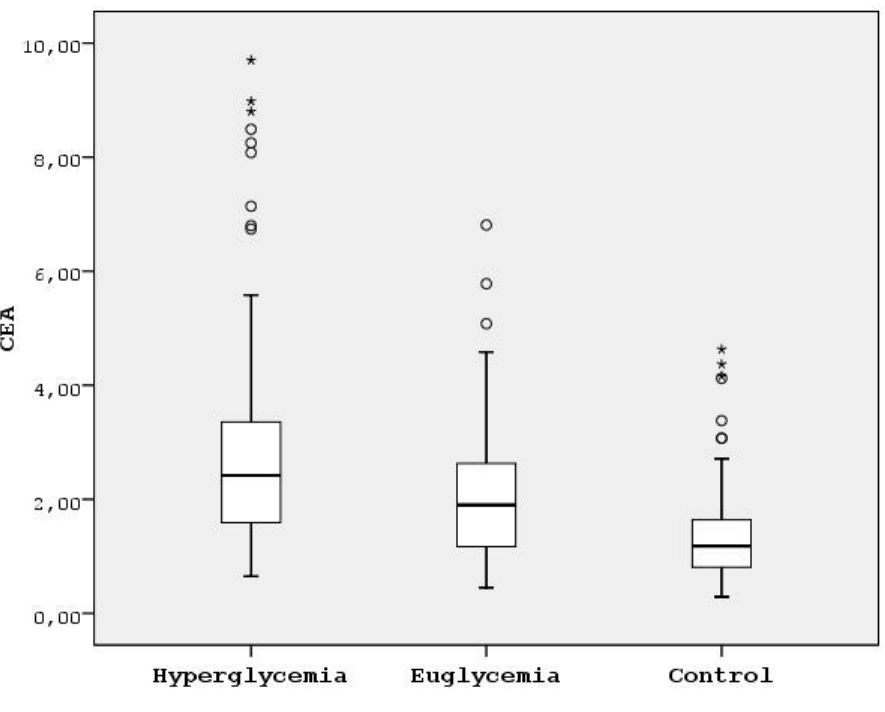
Figure 2: Comparison of CEA levels between the